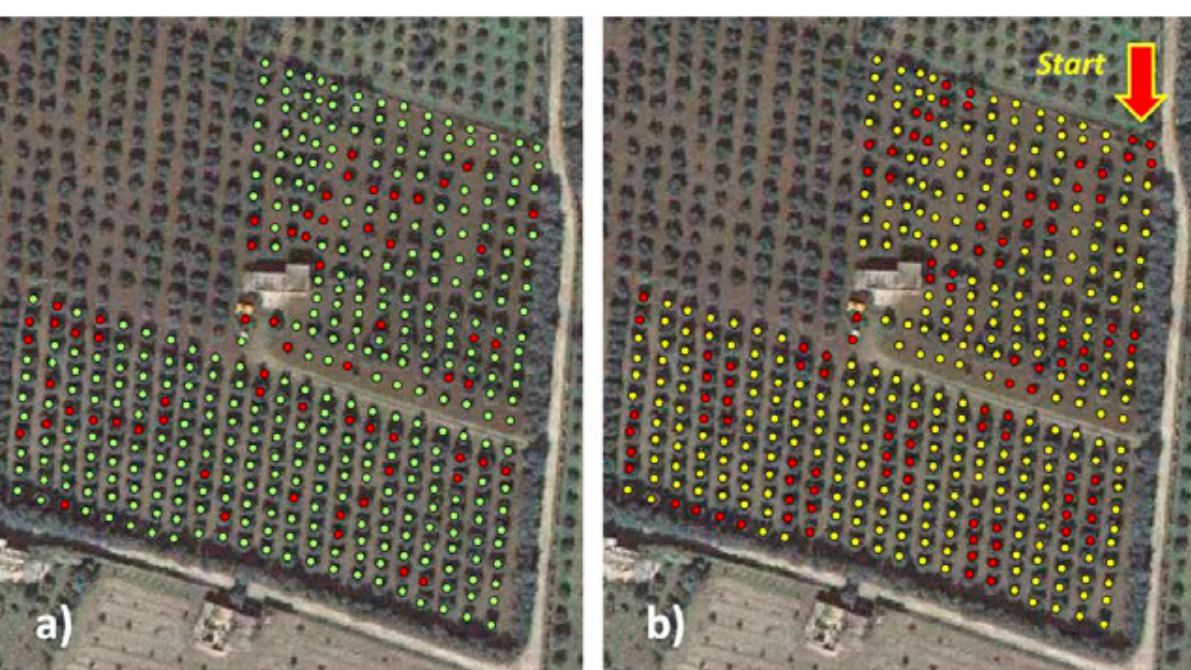
Figure 5. Spatial spread of the infection (a) and monitoring sampling scheme (b) in grove A. The red points show (a) the Citrus tristeza virus infected trees obtained by testing all of the trees by Direct Tissue Blot Immunoassay (DTBIA); while the green points are DTBIA-negative trees; (b) the 25% of sampled trees following the sampling scheme by quadrants used for the Mediterranean Agronomic Institute of Bari sampling method (MAIB-S) and the Hierarchical Sampling method (HS). The red arrow indicates both the starting point and the orientation of the sampling